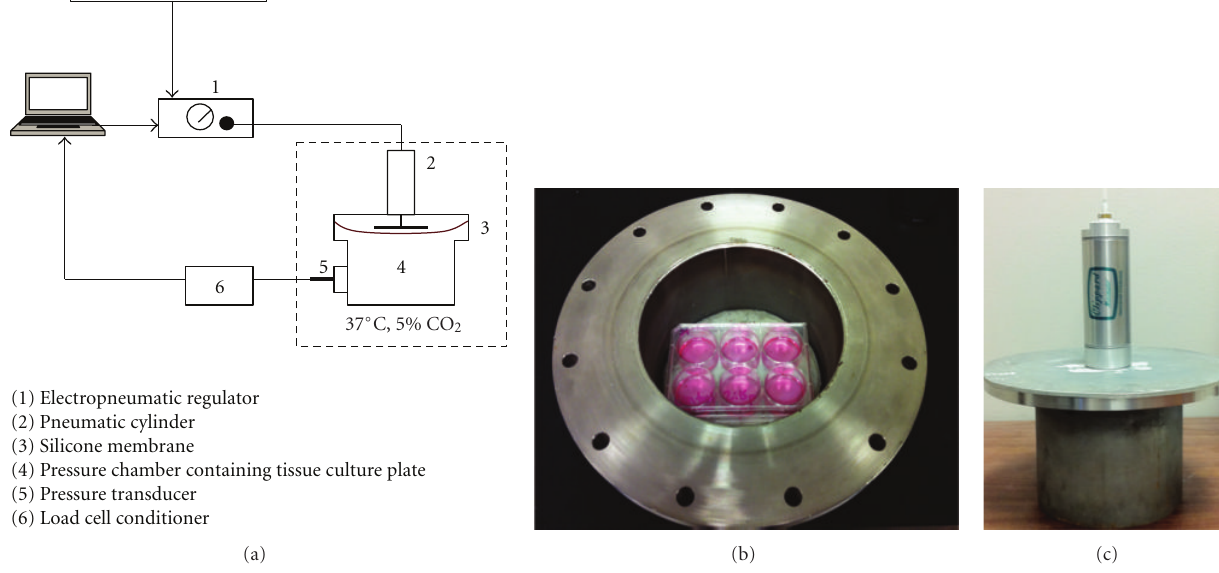
Figure 2: (a) Schematic diagram of the pressure system. A computer controls an electropneumatic regulator (1), controlling the flow of compressed air to a pneumatic cylinder (2) the cylinder exerts a compressive force on a silicone membrane (3) reducing the volume in the pressure chamber (4) and subsequently increasing the atmospheric pressure surrounding the leaflets that are in tissue culture plates in the chamber. A pressure transducer (Omega Engineering, Inc, PX302-200GV) (5) records the internal pressure of the chamber, which is relayed back to the computer via a load cell conditioner (Encore Electronics, Inc., Model 4025-101) (6). The voltage and the pressure signal were acquired with a data acquisition card module (Measurement Devices, PMD1608) and monitored using an in-house developed LabVIEW graphical user program (LabVIEW, National Instruments). The system was placed inside an incubator to maintain a 37 ◦ C, 5% CO 2 humidified atmosphere. (b ) Photograph of a six-well plate in the pressure chamber before being sealed. (c) Photograph of the sealed pressure chamber prior to being place in the 37 ◦ C incubator.